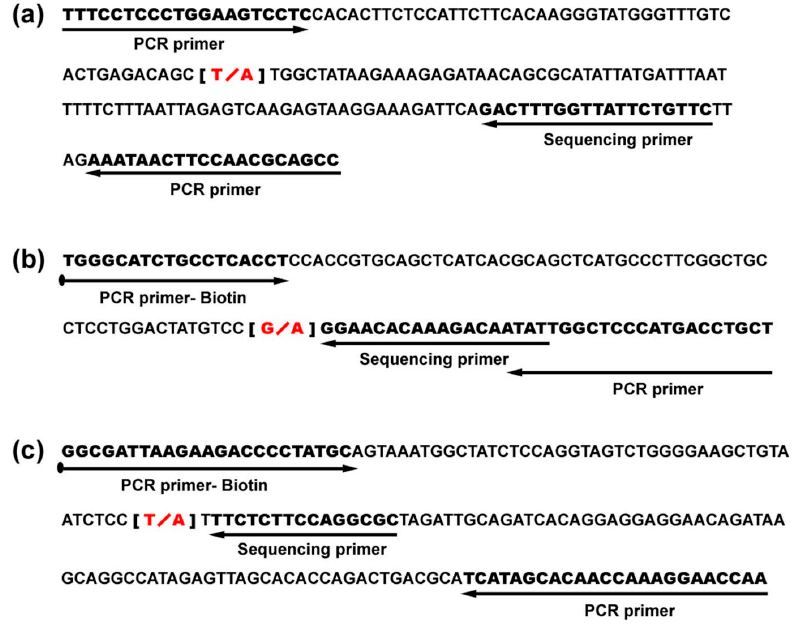
Figure 3. Specific primers for KDR, EGFR, and FGFR2 were used in this study: ( a ) primers for